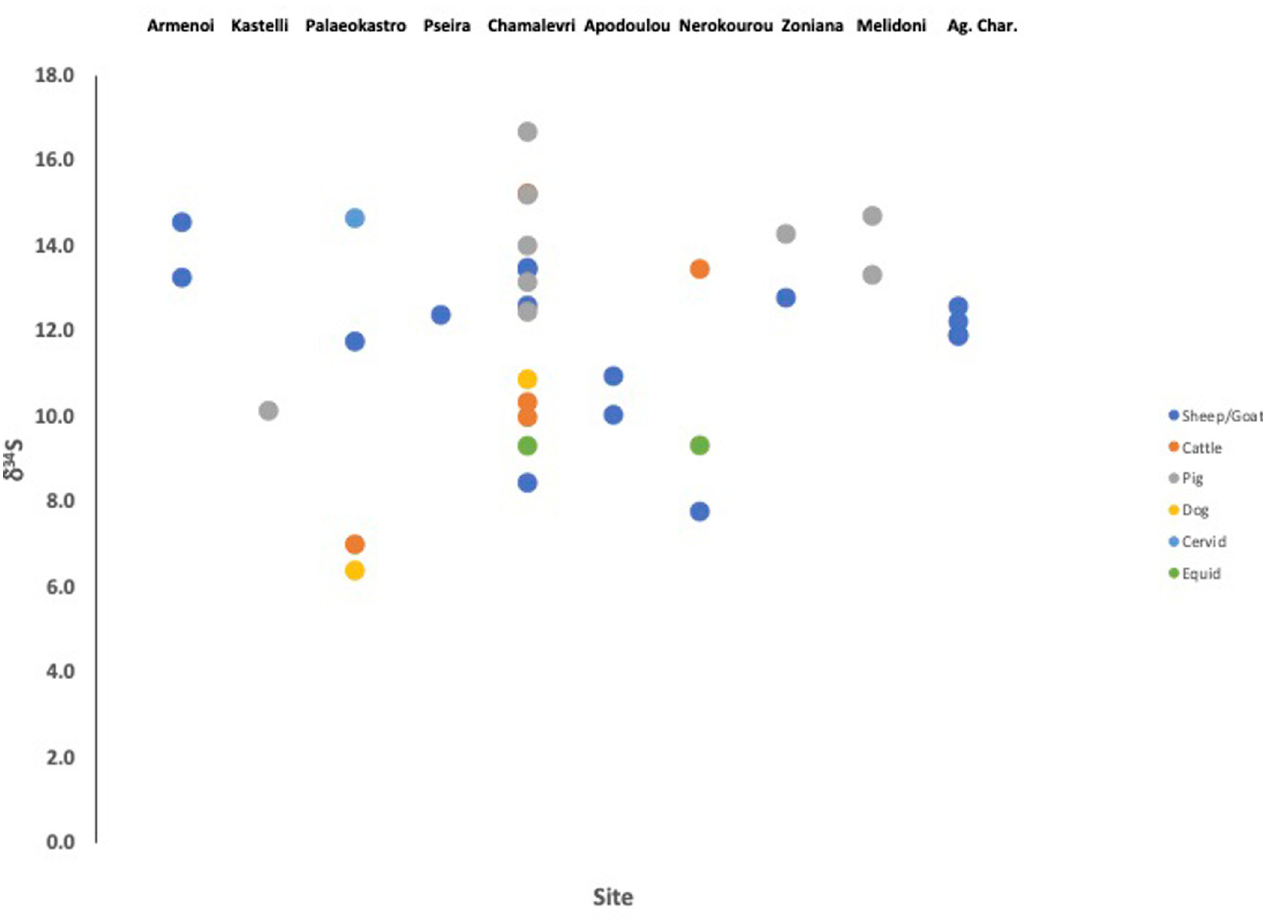
Fig 3. Sulphur isotope values of faunal bone collagen from archaeological study sites in